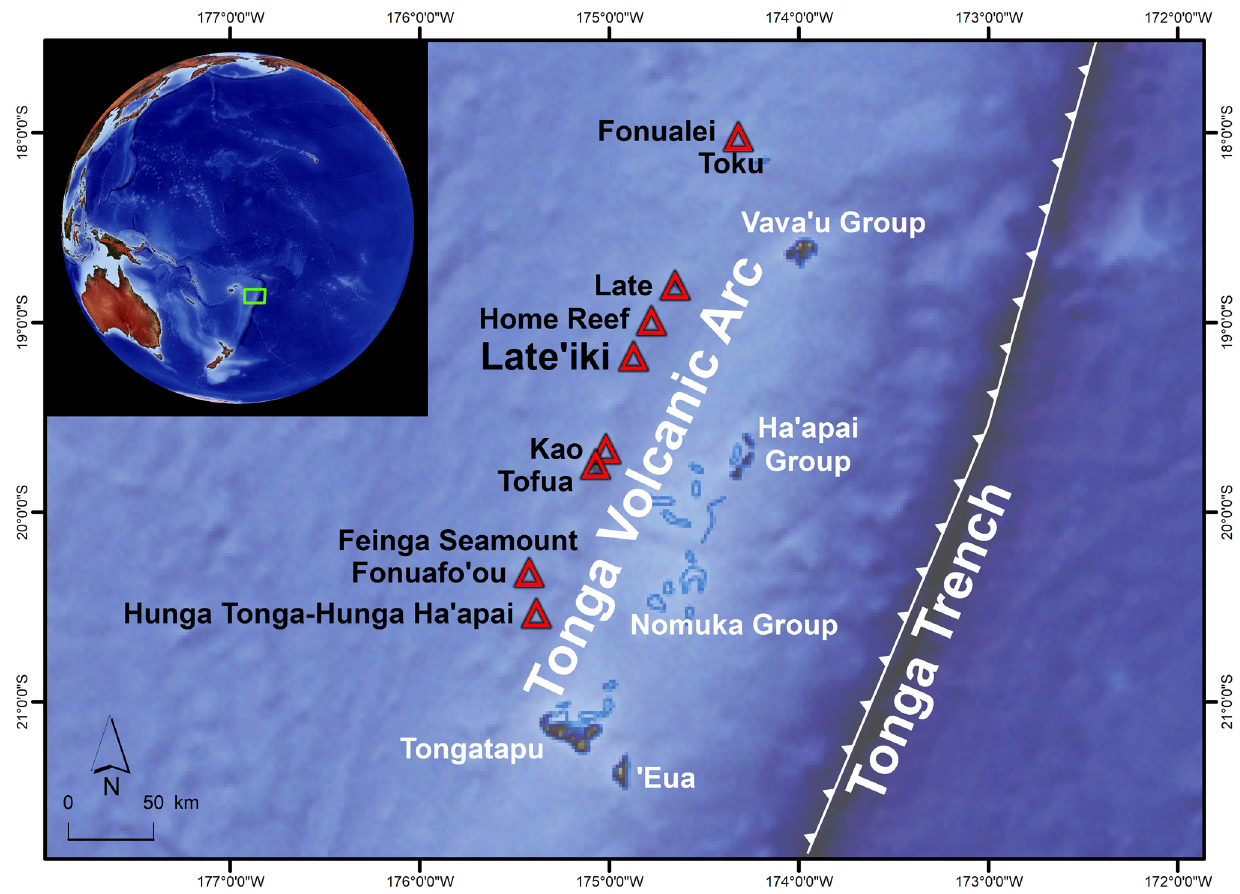
Figure 1. Late’iki is one of several submarine and island volcanoes (red triangles) located on the Tonga Volcanic Arc, west of the Tonga Trench in the South Pacific. Besides at Late’iki Volcano, surtseyan eruptions were also observed at Home Reef in 2006 46 and at Hunga Ha’apai in 2009 59 and in 2014/2015 1 . The green rectangle marks the location of the detailed map. Map changed after 4 and 60 . Background: Made with Natural Earth